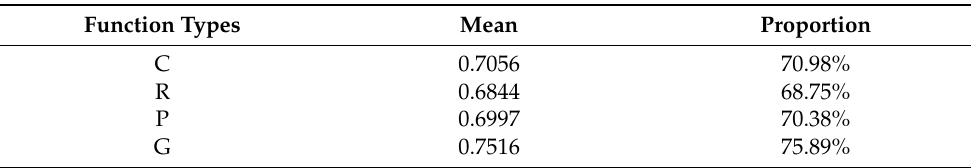
Table 7. The statistical results of sentiment analysis in the functional zone: “mean” represents the mean value of the sentiment score, and “proportion” represents the proportion of positive sentiment Weibo check-in